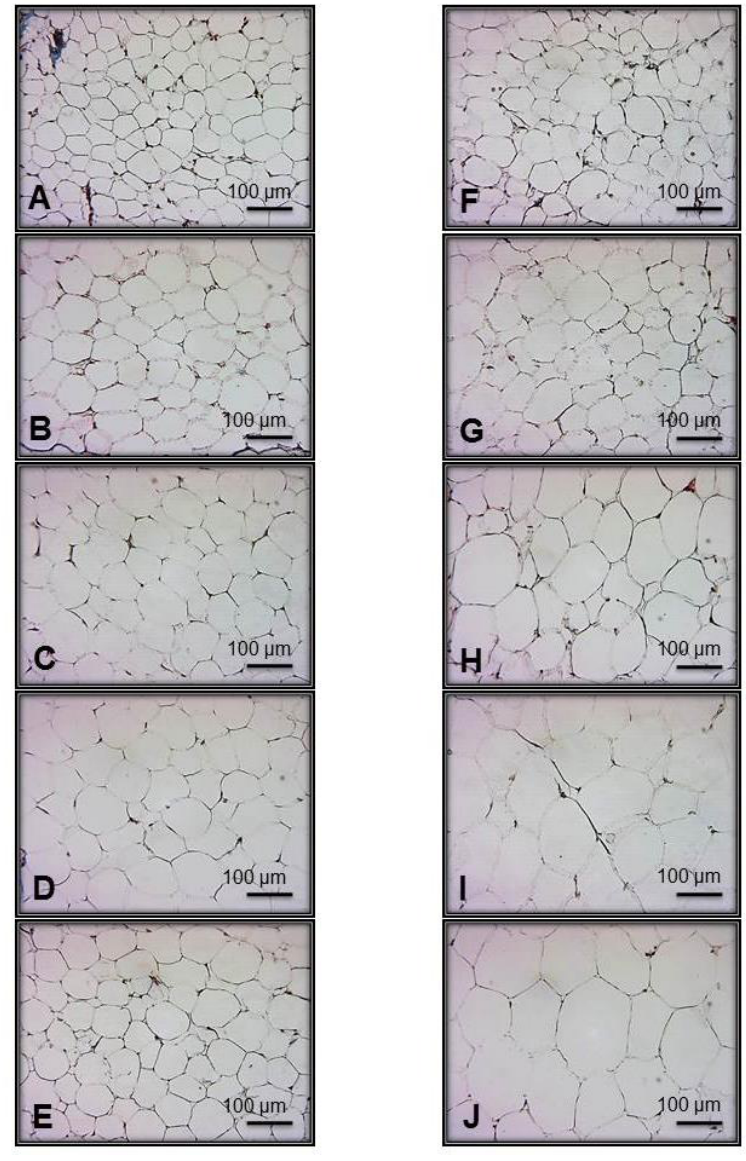
Figure 2. Representative photomicrographs of intra-abdominal white tissue from the experimental groups that show adipocyte size. Five fields per sample were analyzed. Panels ( A ) 1 M, ( B ) 2 M, ( C ) 3 M, ( D ) 4 M and ( E ) 5 M represent the C, and panels ( F ) 1 M, ( G ) 2 M, ( H ) 3 M, ( I ) 4 M and ( J ) 5 M represent the MS groups. n = 7 rats per experimental group. Abbreviations: C = Control; MS = Metabolic syndrome; M = Month.